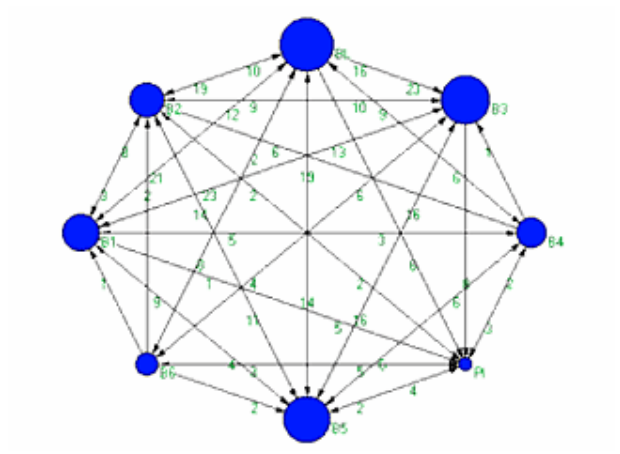
Figure 19. Directed network of hubs in the blue